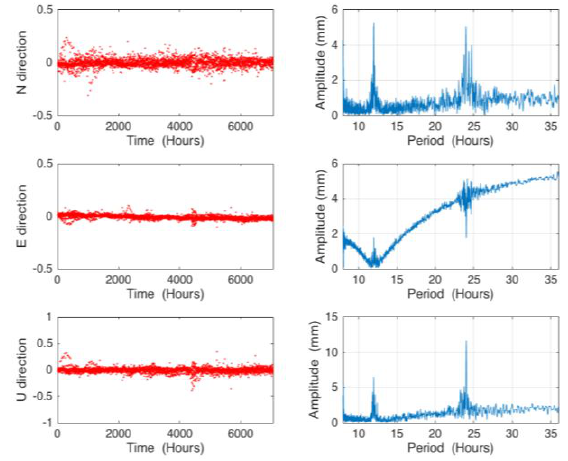
Fig 4. Coordinate time series (left) and spectrum analysis (right) of GDZJ